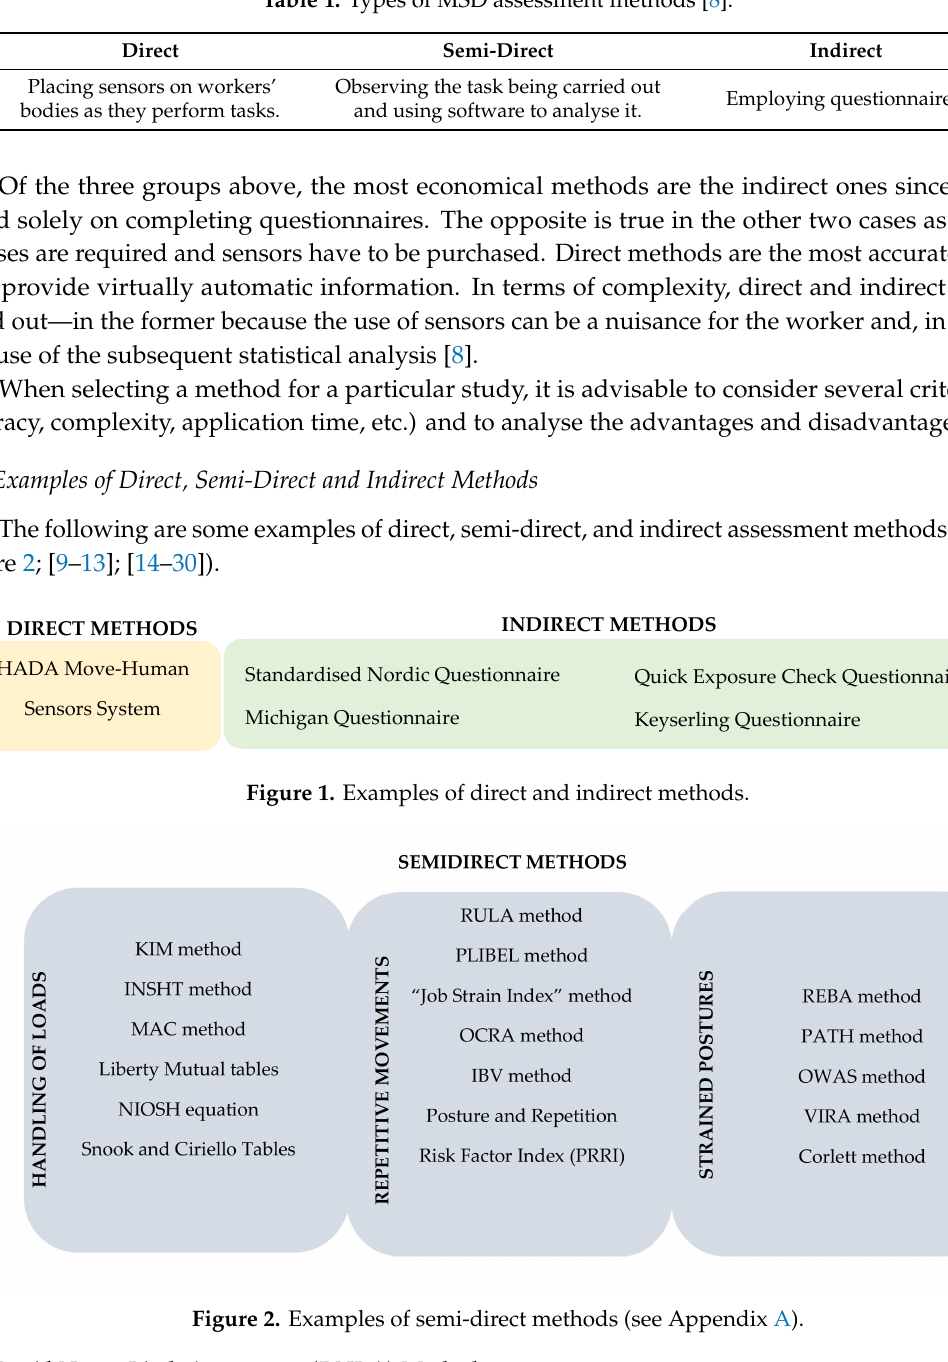
Figure 2. Examples of semi-direct methods (see Appendix A).